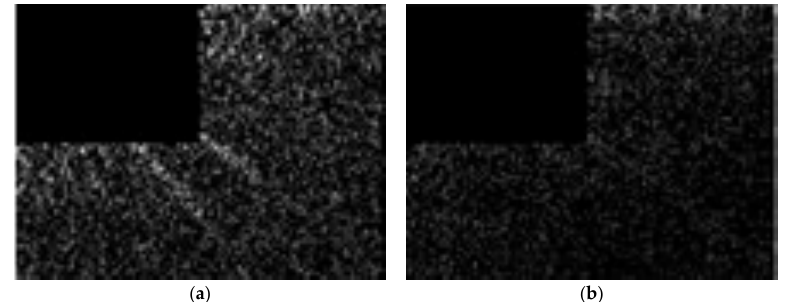
Figure 5. The DCT images which can be used to estimate the water level ( a ) or not ( b ).